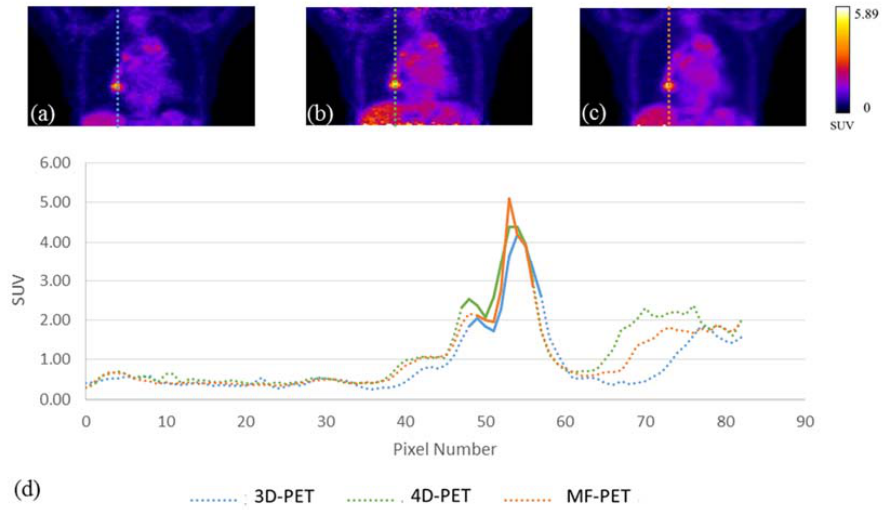
Figure 1. The coronal views of the positron emission tomography (PET) images from ( a ) 3D, ( b ) 4D (T55%), ( c ) Motion Freeze technology (T55%-based) for patient number 10, and ( d ) vertical image profiles drawn across the standardized uptake value (SUV) max voxel of the lesion on Motion Freeze (MF)-PET image and the profiles of 3D-PET and 4D-PET were both drawn on the same location. The solid line indicated the area over the threshold of 40% SUV max .